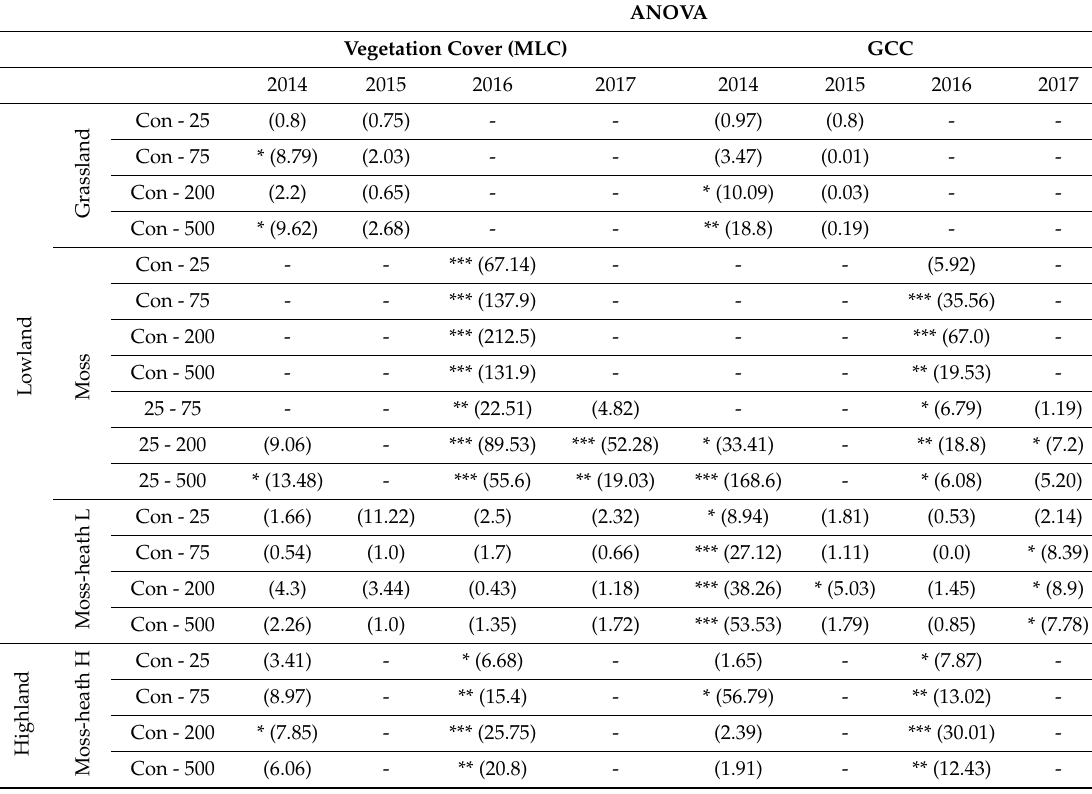
Table 2. Analysis of variance (ANOVA) with f-values for vegetation cover in percent (MLC) and Green Chromatic Coordinate (GCC) greenness index. Significance levels: *** ( p < 0.001), ** ( p <